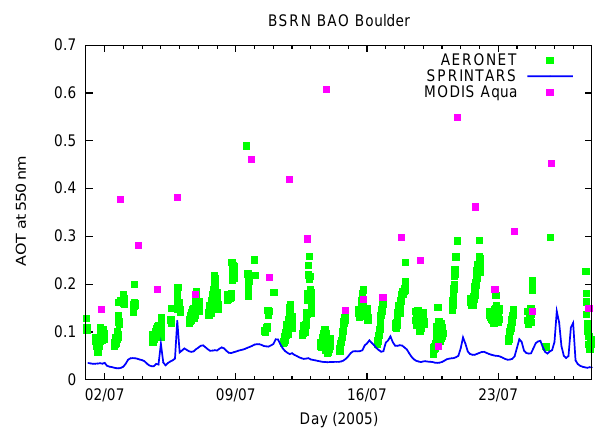
Fig. 19. Observed AOT at Boulder for AERONET and MODIS Aqua. Also shown is the standard SPRINTARS’ AOT. MODIS clearly overestimates AOT for this site.